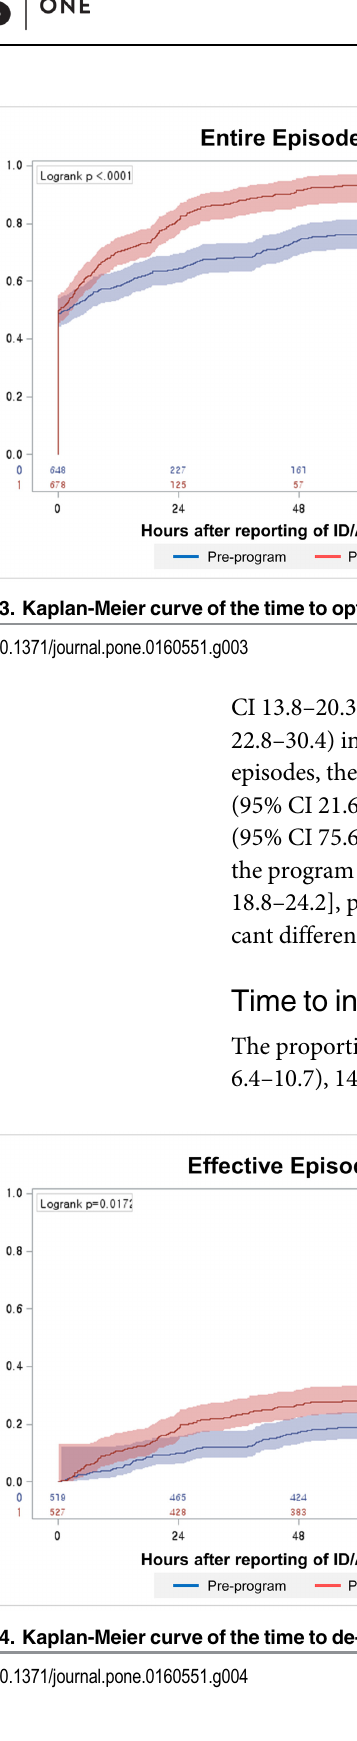
PLOS ONE | DOI:10.1371/journal.pone.0160551 August 17,